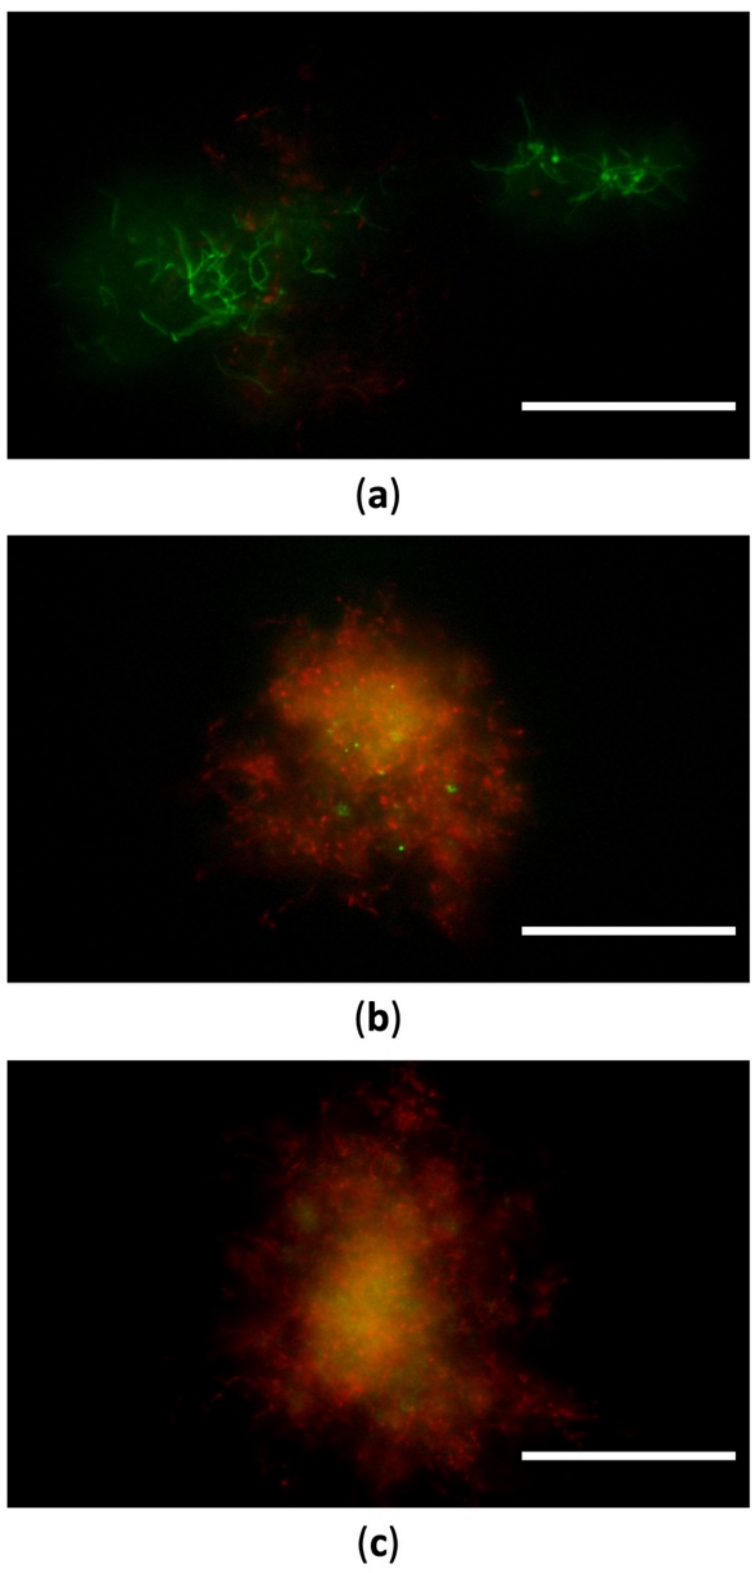
Figure 4. Fluorescence microscopy of Micromonospora unchallenged cells ( a ) and those grown in the presence of either 100 ( b ) or 250 μ M TeO 3 2 − ( c ) for 24-h. Scale bar 50 μ m.